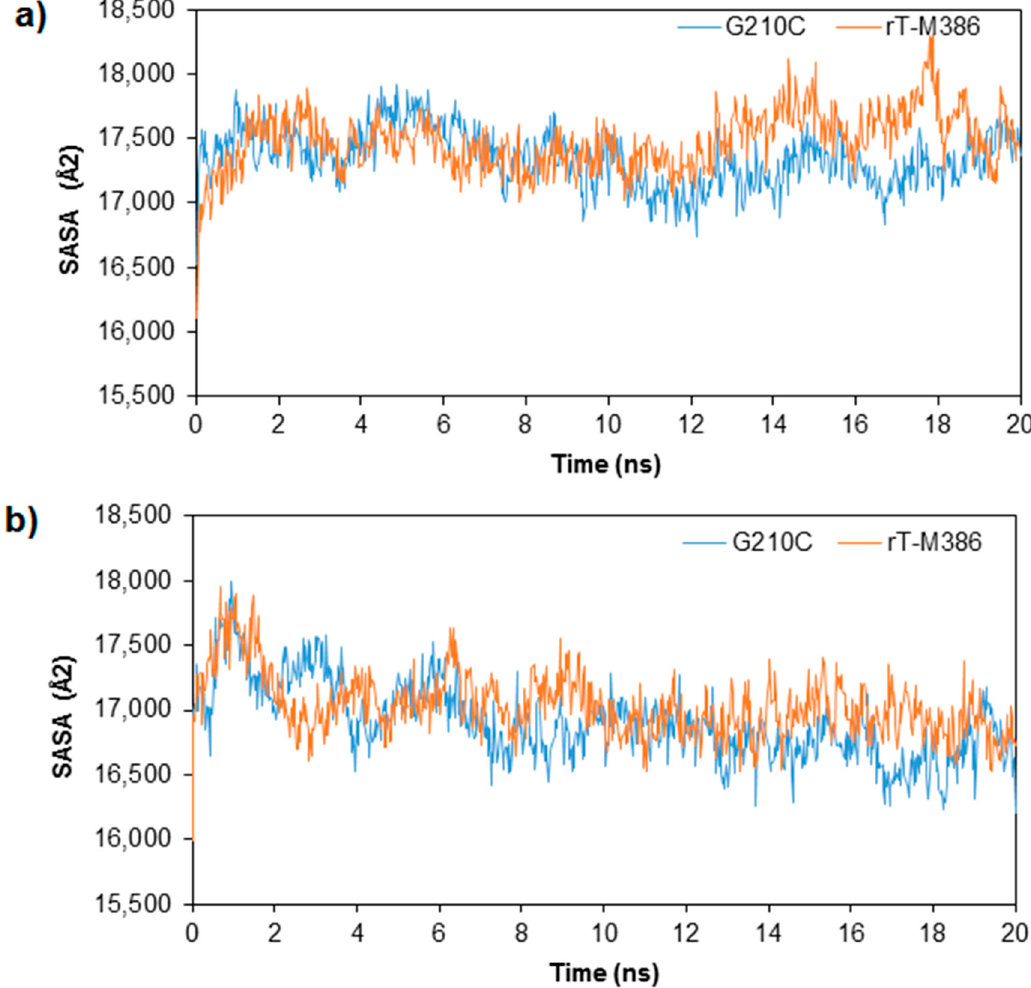
Figure 5. Solvent accessible surface area (SASA) of rT-M386 and G210C as per time. ( a ) at 25 ◦ C ( b ) at 50 ◦ C. The simulation was analyzed over 20 ns trajectories. The SASA of rT-M386 and G210C lipases are indicated by red and blue lines, respectively.